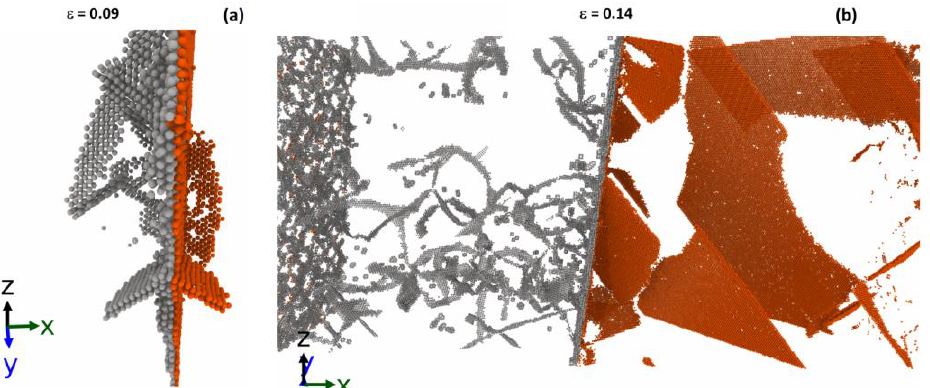
Figure 7. Development of plastic deformation in the bisystem at initial pressure of 10 GPa: ( a ) emission of the leading and trailing partial dislocations into aluminum and the leading dislocations limiting stacking faults into copper; ( b ) development of a dislocation network in aluminum with the formation of vacancies and expansion of stacking fault planes in copper. Aluminum atoms are grey colored, copper atoms are orange colored; only the atoms with high values of the centrosym- metry parameter are